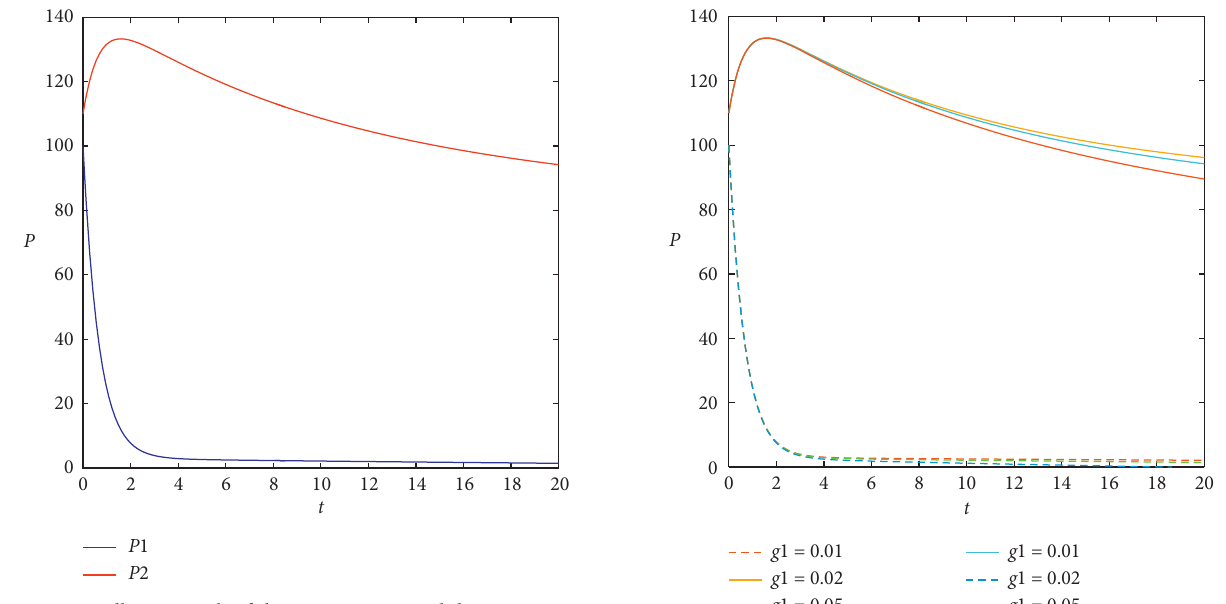
and downstream P . 1 2 Figure 4: Sensitivity analysis of pollution stock.